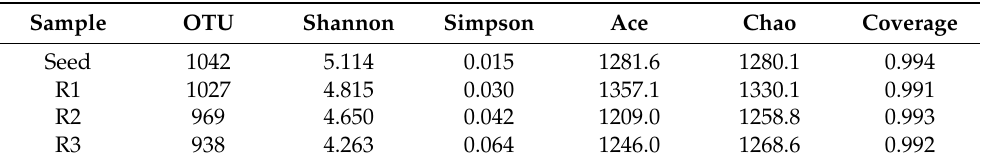
Table 1. Similarity-based OTUs, richness, and diversity estimators of microbial communities of the granular consortia sampled in seed sludge, R1, R2, and R3, respectively. Sample OTU Shannon Simpson Ace Chao Coverage Seed 1042 5.114 0.015 1281.6